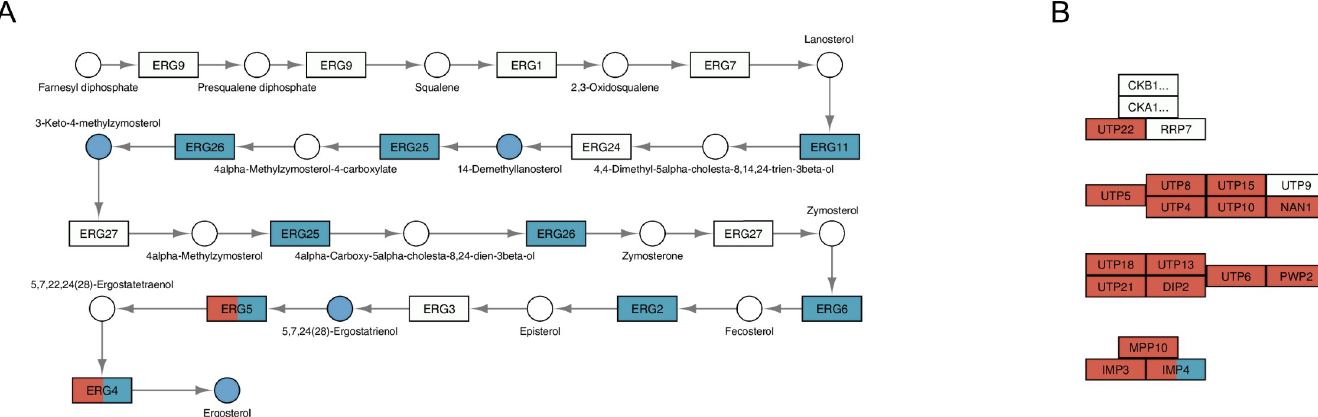
Fig 8. KEGG pathways regulated by GPA2 or ASC1 as determined by sensitivity analysis. The relevant part of a specific KEGG pathway is shown with genes displayed as rectangles and metabolites displayed as circles. KEGG compound name for each metabolite is labeled beside the circle. Standard gene names are labeled inside the rectangle. For enzyme complexes, the gene name for the major component is shown followed with an ellipsis. The directions of irreversible enzymatic reactions are shown by the arrows. Reversible reactions are connected by straight lines. s-DEGs and s-SPMs are highlighted in blue ( gpa2 ) and red ( asc1 ). Shared s- DEGs and s-SPMs are colored half blue and half red. A) as compared with asc1 , gpa2 affected more components in steroid biosynthesis (functional category: lipid); B) as compared with gpa2 , asc1 affected more components in ribosome biogenesis (showing 90S pre-ribosome components, functional category: genetic information